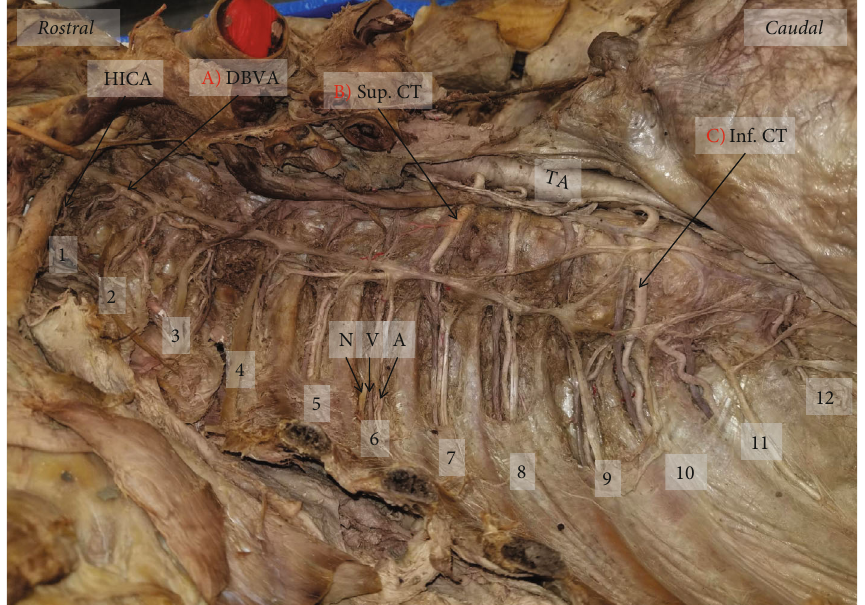
Figure 3: Right posterior thoracic wall with exposed intercostal spaces: (a) the descending branch of the vertebral artery supplying the 1st- 3rd ICS; (b) superior common trunk arising from TA between7th and 8th thoracic vertebrae supplying 4th-7th ICS; (c) inferior common trunk arising from TA between 10th and 11th thoracic vertebrae supplying 9th-11th ICS. Numbers 1-11: ICS number; 12: subcostal space; HICA: highest intercostal artery; DBVA: descending branch of the vertebral artery; Sup. CT: superior common trunk; TA: thoracic aorta; Inf. CT: inferior common trunk; N: nerve; V: vein; A: